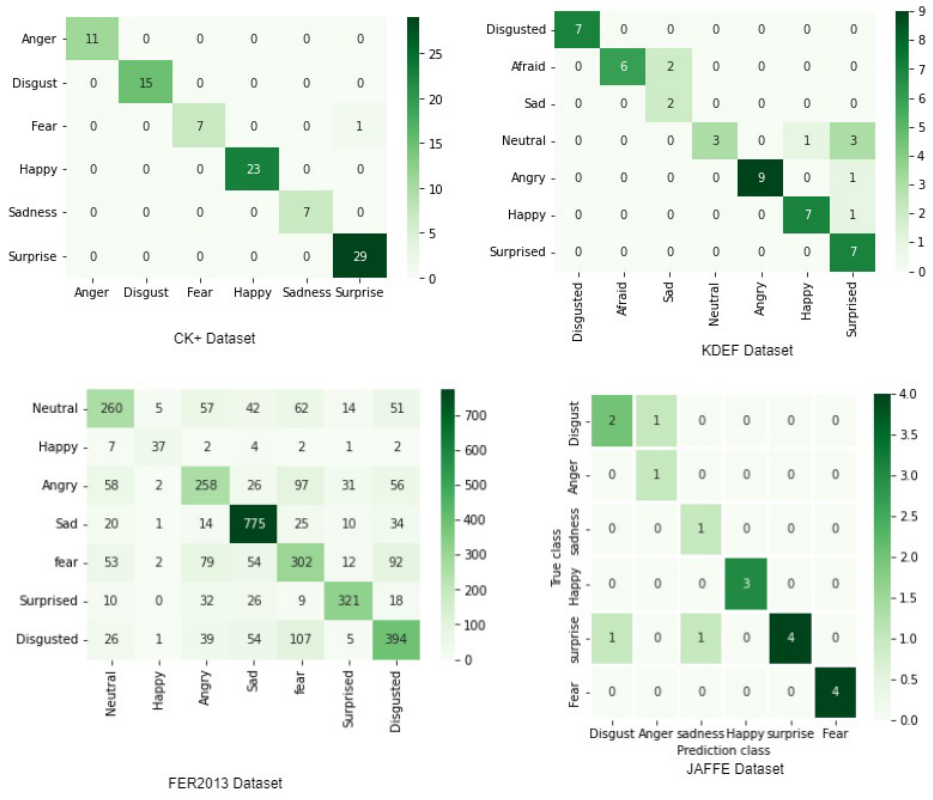
Figure 9. The Confusion matrix obtained by EfficientNet-XGBoost on CK+, JAFFE, KDEF and FER2013.